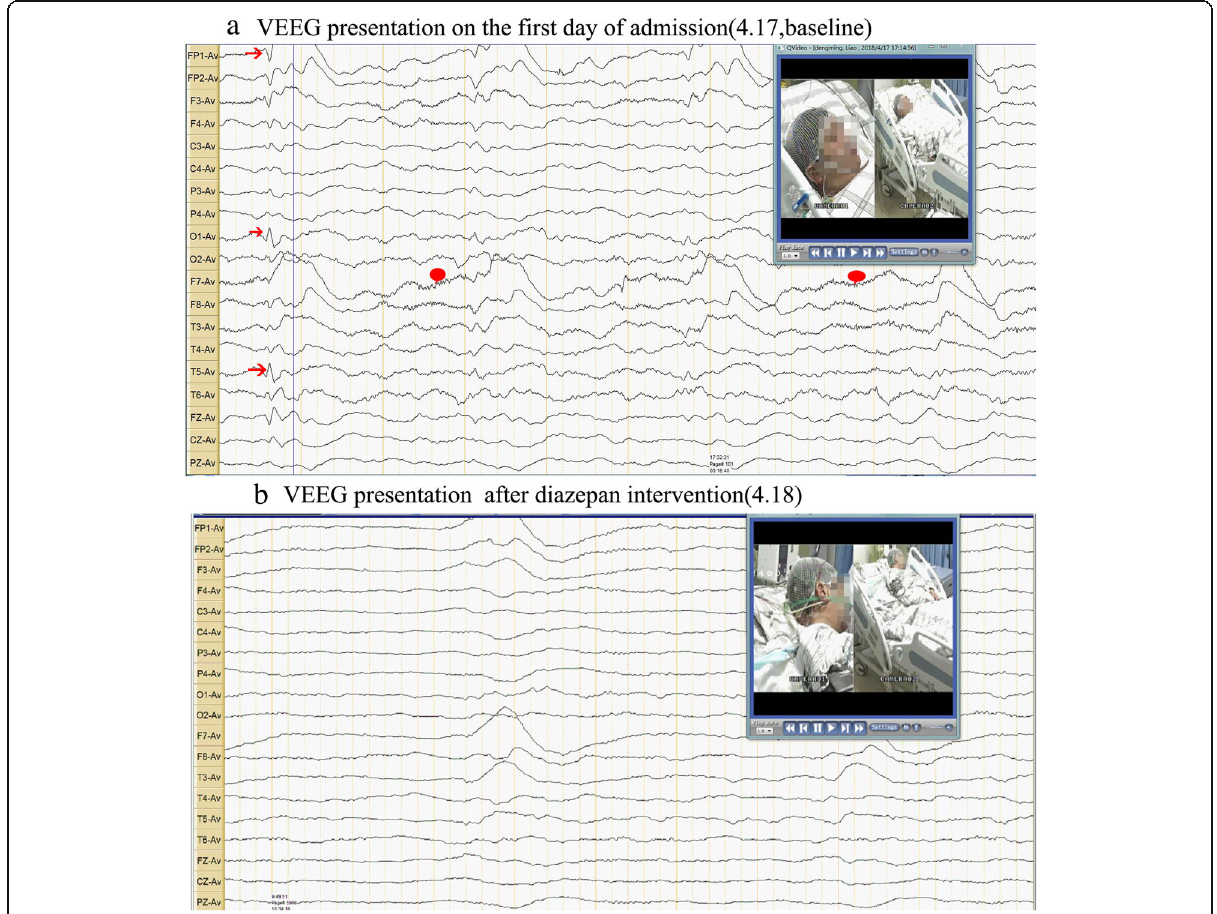
Fig. 3 Continuous video electroencephalography (CVEEG) presentation before and after diazepam intervention. a Video electroencephalography (VEEG) presentation on the day of admission. CVEEG showed diffuse slowing in the theta and delta range and periodic sharp-slow wave discharges (once/2 – 3S, as the red arrows showed) that correlated with the patient ’ s rhythmic lip smacking movements (as the red dots showed). b VEEG presentation after diazepam intervention. The periodic discharges and rhythmic lip smacking movements were terminated after diazepam